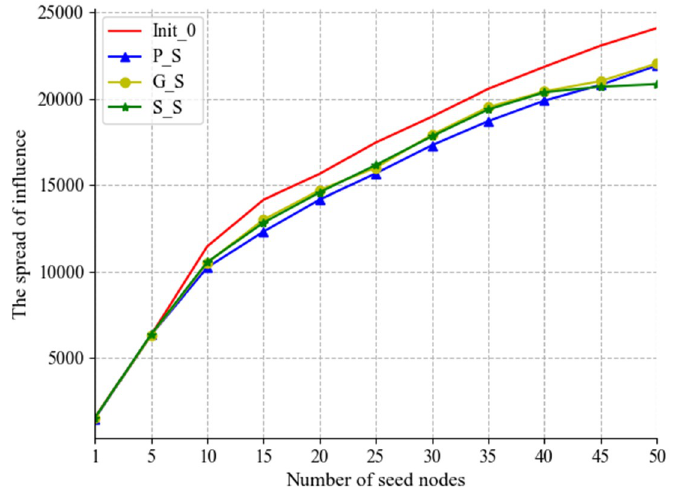
Figure 6. Influence spreading of the new seed set obtained by G_S, P_S and S_S.